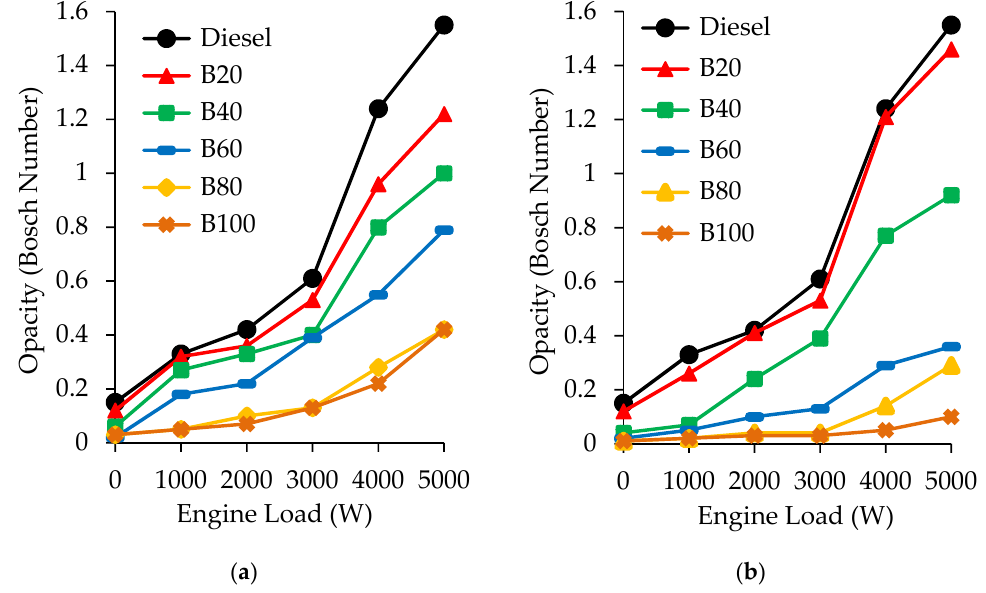
Figure 5. Smoke emissions (Bosch number) at different engine loads (1000–5000 kW) for ( a ) diesel/ethyl acetate/sunflower oil; ( b ) diesel/ethyl acetate/castor oil blends.